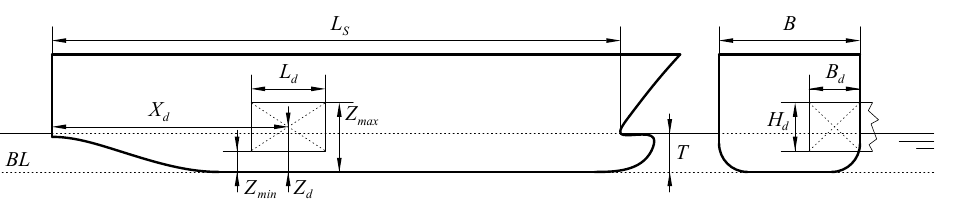
Figure 3. Bow-shaped damage